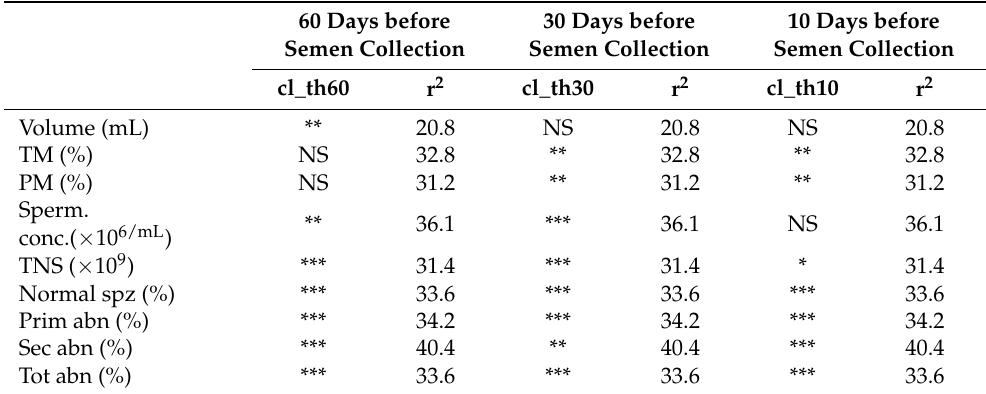
Table 5. Interaction between the THI, 60, 30, and 10 days before semen collection with seminal parame- ters, with level of